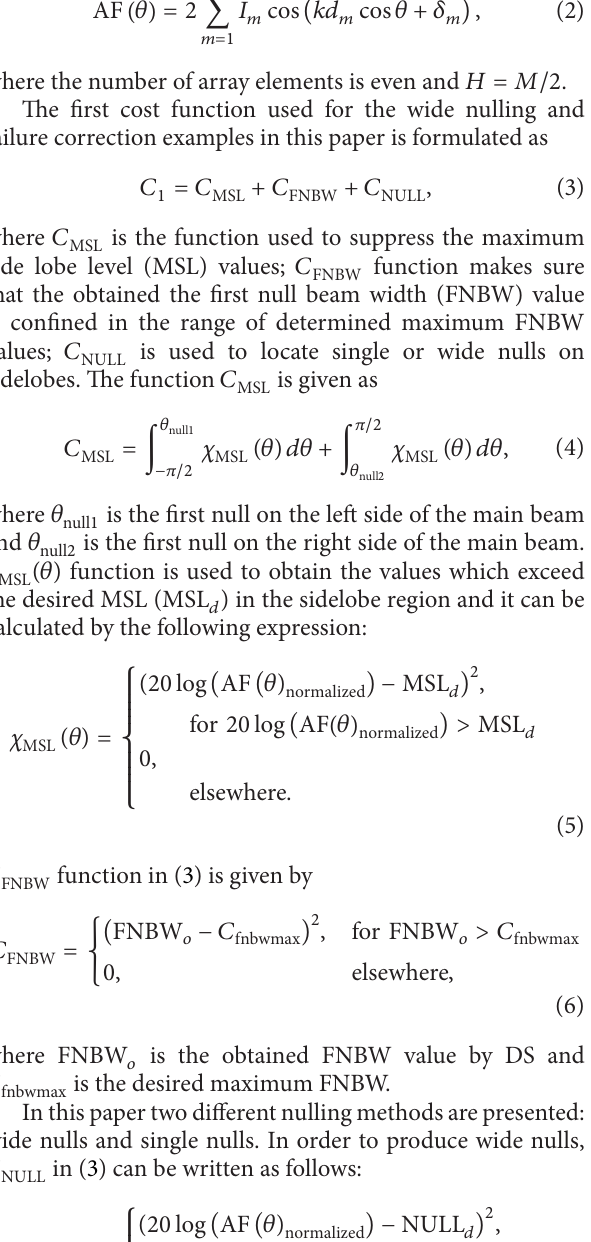
algorithm [12], harmony search algorithm [13], and